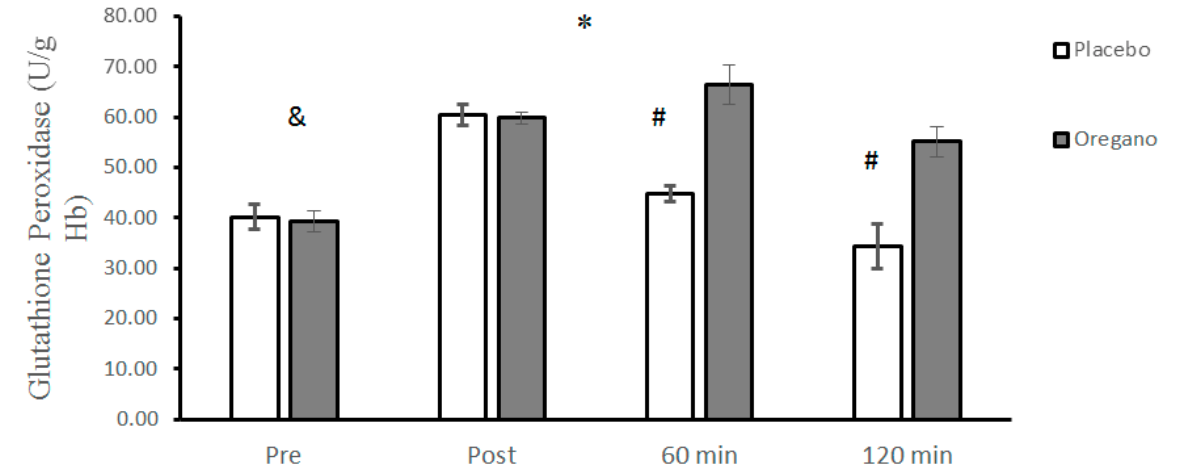
Figure 5. Mean ± standard deviations (SD) of plasma GPX levels before and at different times after consuming oregano supplements. The asterisk (*) indicates significant time × group interaction, (#) indicates a significant difference between the two groups, and (&) indicates significant main effect of time ( p < 0.05).